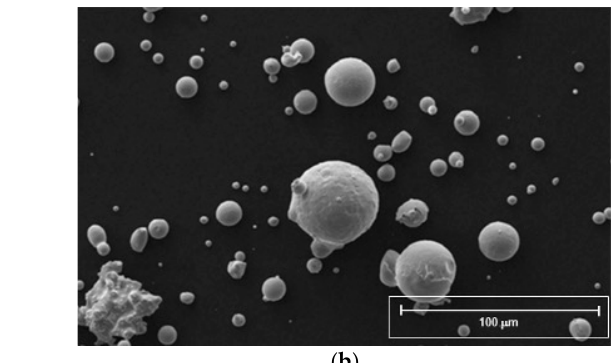
Figure 1. Particle size distribution of the as-received powders of FeSi3 and FeSi6.5 steels, used in the L-PBF system. Table 2. Particle size distribution measured by the laser diffraction method. D 10 , D 50 , and D 90 mean the particle size at 10 vol%, 50 vol%, and 90 vol%, respectively.